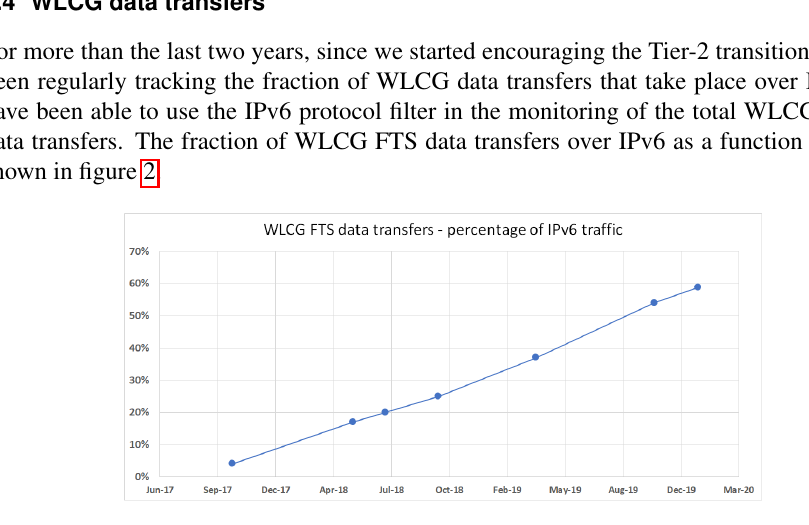
Figure 2. Percentage of FTS data transfers over IPv6. Each data point shows the average percentage over the previous 30